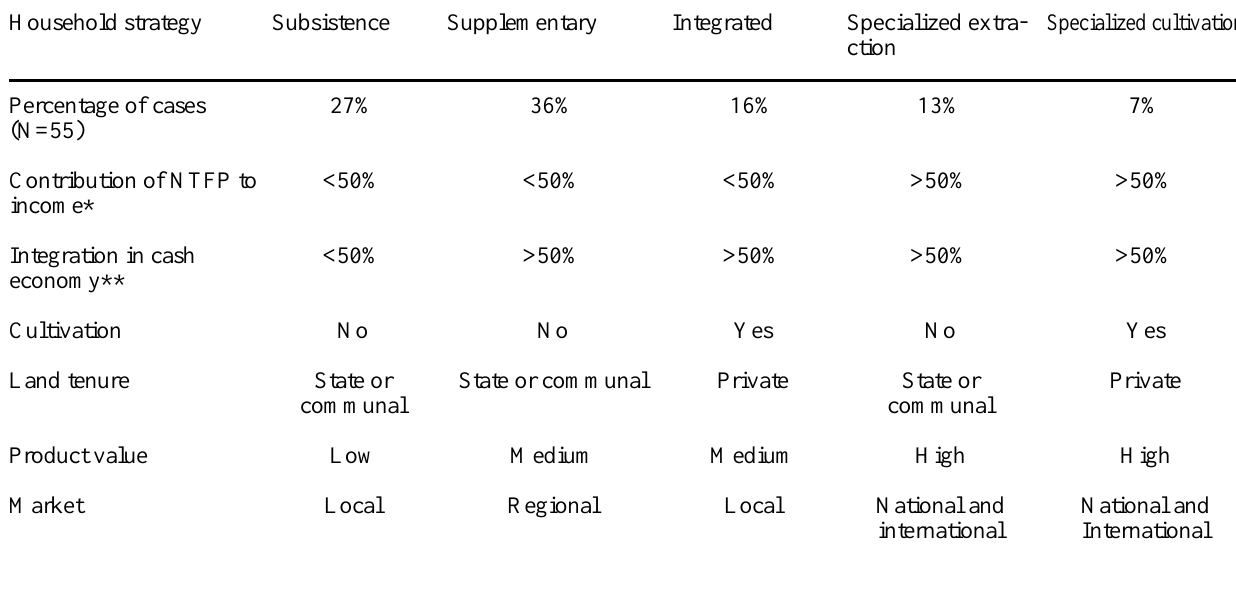
Table 3. A typology of nontimber forest product- (NTFP) related household strategies: dominant characteristics based on Belcher et al.